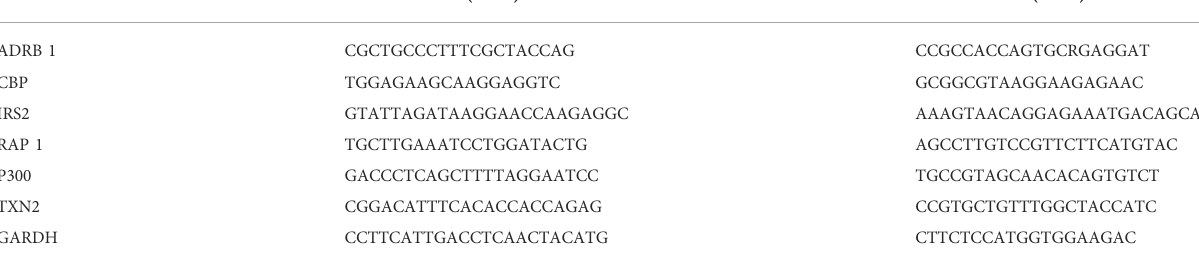
TABLE 1 Primer sequences forward and reverses (5 ’ -3 ’ ).